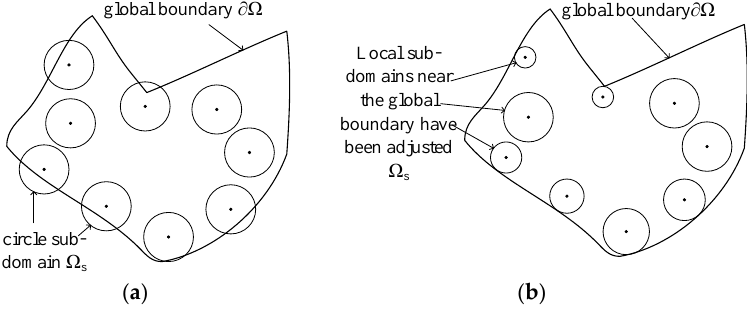
Figure 1. ( a ) The intersection between the local sub-domain and the global boundary; ( b ) the local sub-domains near the global boundary have been adjusted.